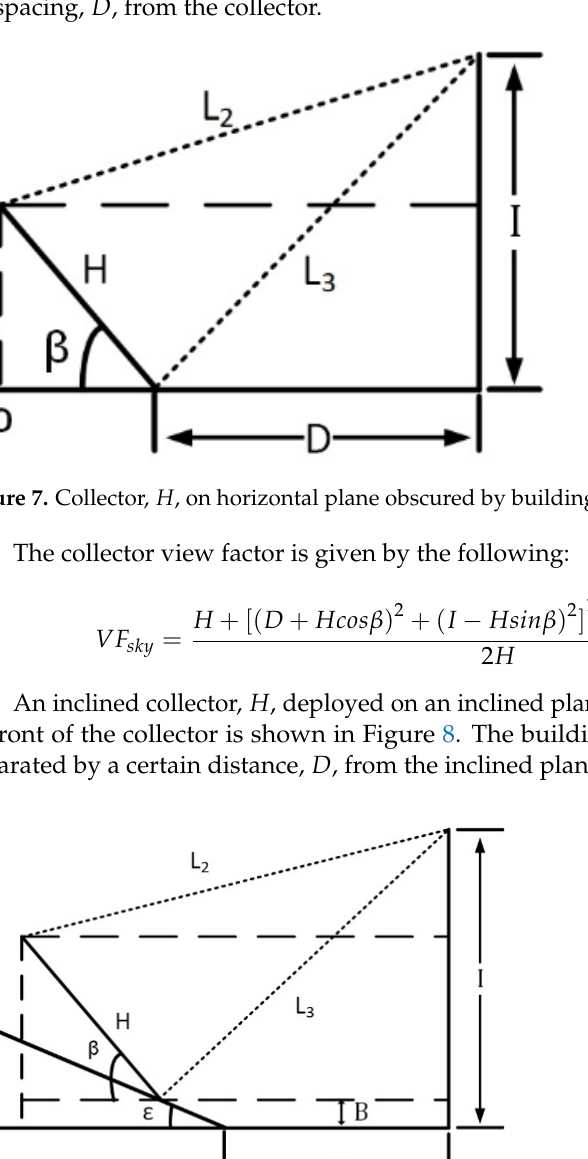
Figure 8. Collector, 𝐻 , on an inclined plane, 𝜀 , obscured by a building ( 𝐼 ) in front.